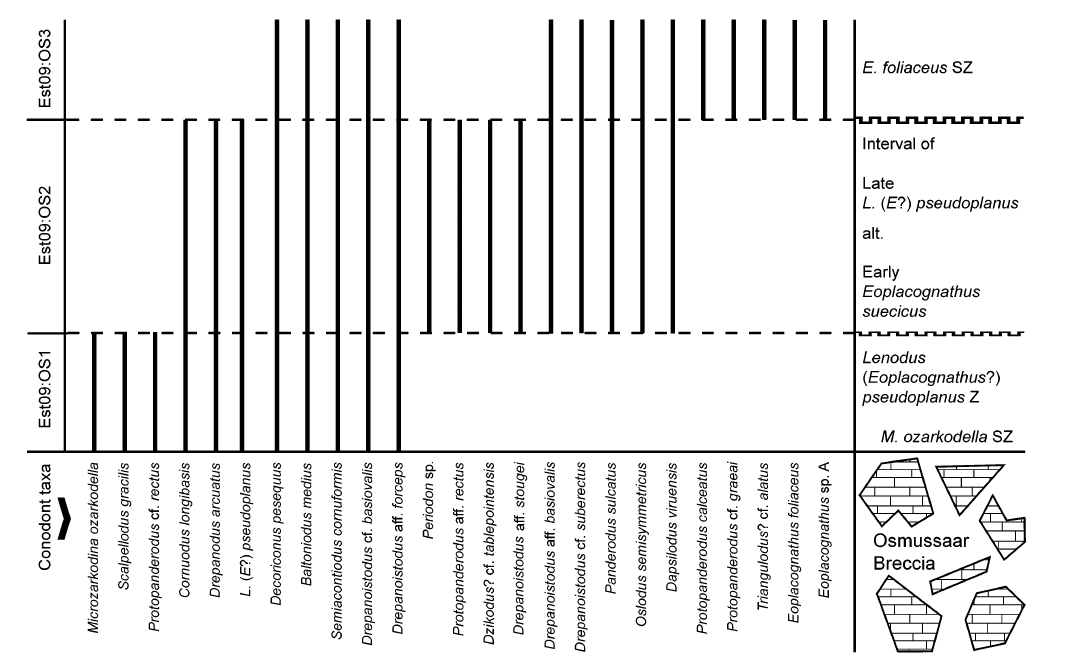
(Fig. 5K) and Protopanderodus cf. rectus (Fig. 5G), each one comprising ≤ 1% of the fauna. Among zonal